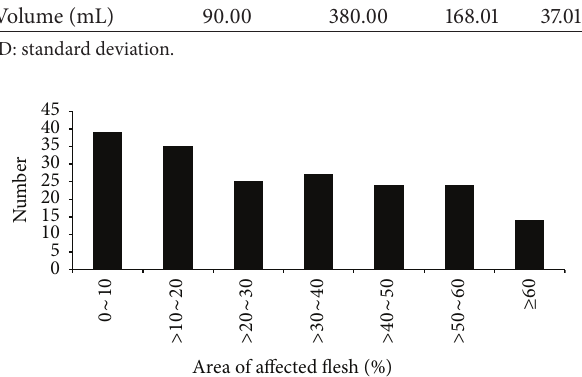
Figure 3: Histogram of blackheart potatoes in various degrees.